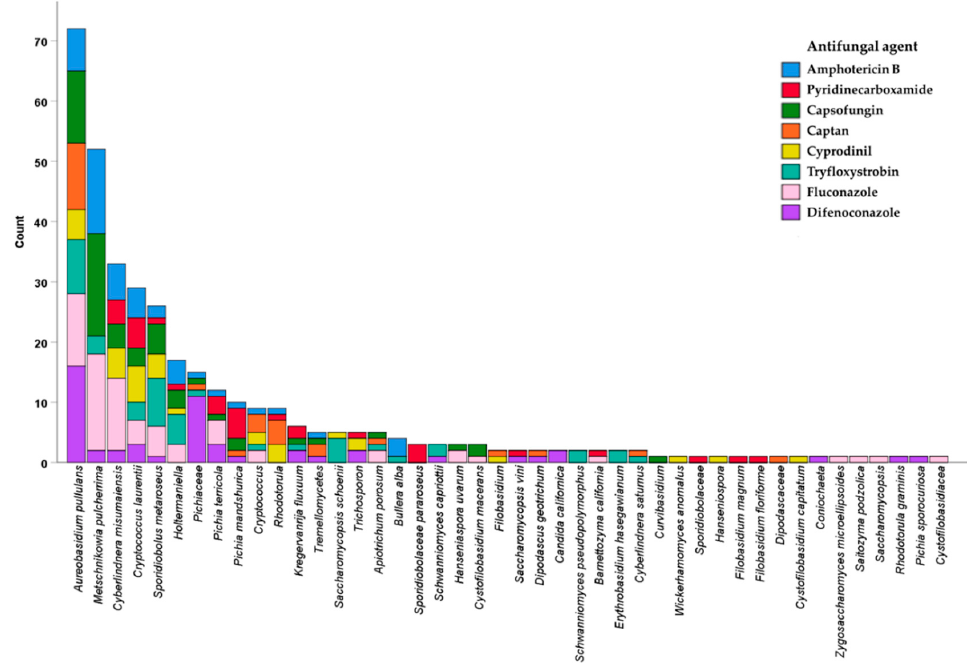
Figure 2. Aureobasidium pullulans is most frequently isolated species in the presence of fungicides. All the yeast taxa (species hypotheses, here referred to as species) that were identified are listed on the X -axis, while the Y -axis indicates the number of isolates obtained for each species. The color codes represent the fungicides used during the isolation, with the corresponding total numbers of isolates. Table 1. Yeast species isolated from soil, flower, leaf, and fruit samples in this study. A. pullulans, Holtermaniella, and S. metaroseus were isolated from all sample types. The species were identified by MALDI-TOF mass spectrometry (MS) as a fast and economical alternative to DNA sequencing. Isolates that could not be identified by MALDI-TOF MS were determined based on the ITS sequence. Those identified by the ITS sequence were assigned species hypotheses (SH numbers) [32,33] . Soil Flower Leaf